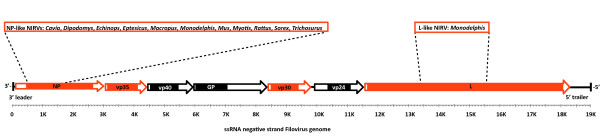
Genome map of a filovirus showing the gene order and regions of homology with proposed filovirus-like elements in mammals. Dashed lines indicate the boundaries of the non-retroviral integrated RNA virus elements (NIRVs) and depict a bias for the N-terminal region of the NP gene. Mammalian genera that show homology with a gene of filovirus are listed above the genome map. Solid colors within the coding region arrows indicate the size of the product. Red shading indicates proteins associated with the viral RNA in the ribonucleoprotein complex.